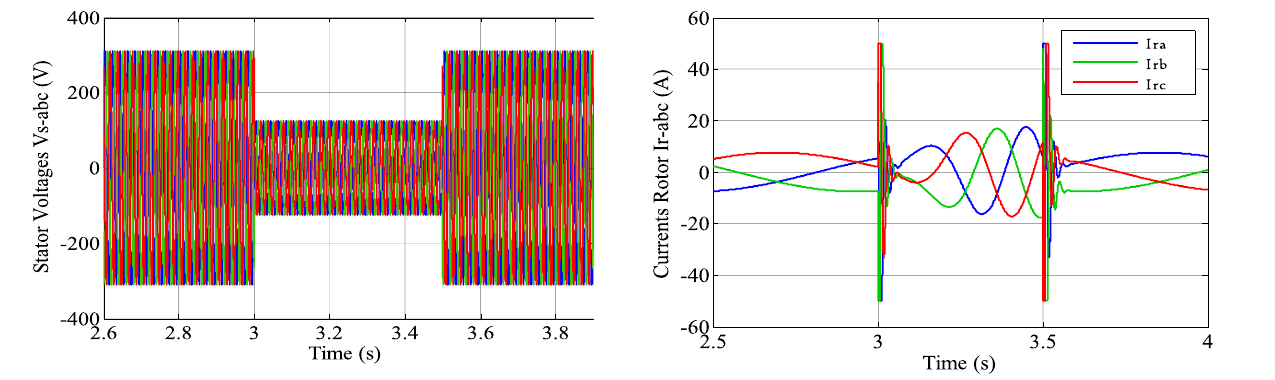
Fig. 4 Symmetrical Voltage dips of 60% ( Δ V s = 186 V)